Question: What does this figure show? Answer in one sentence.
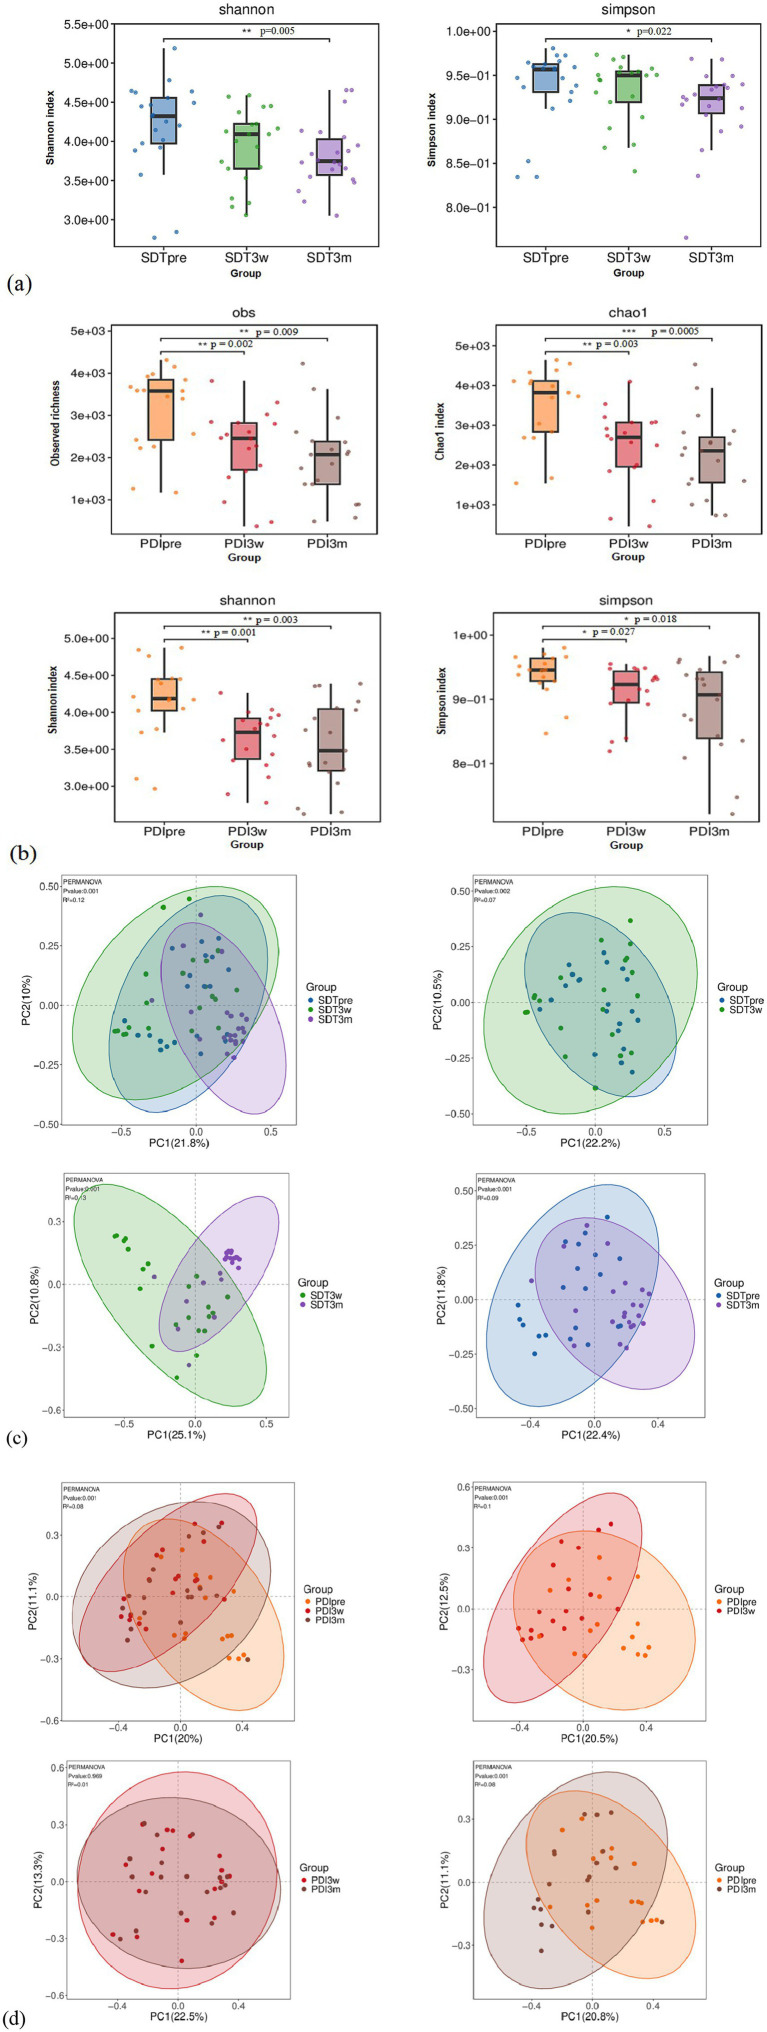
Answer: Within-group longitudinal changes in gut microbiota diversity. (a,b) α-diversity indices (Shannon, Simpson, Obs, and Chao1) in the SDT (a) and PDI (b) groups at preoperation (Pre), 3 weeks (3w), and 3 months (3 m) postoperatively. Box plots show the median, interquartile range, and distribution. Statistical significance is indicated above the plots (* p < 0.05, ** p < 0.01, *** p < 0.001). (c,d) PCoA based on Bray–Curtis distance illustrating structural shifts across the three time points in the SDT (c) and PDI (d) groups. Each dot represents one sample; percentages in parentheses indicate variance explained by each principal coordinate (PC). Between-time-point differences were assessed by PERMANOVA (999 permutations), with p -values and R 2 values shown in the panels. SDTpre, samples collected 1 day preoperatively from the stent-based diversion technique group; SDT3w, samples collected 3 weeks postoperatively from the stent-based diversion technique group; SDT3m, samples collected 3 months postoperatively from the stent-based diversion technique group; PDIpre, samples collected 1 day preoperatively from the prophylactic double-lumen ileostomy group; PDI3w, samples collected 3 weeks postoperatively from the prophylactic double-lumen ileostomy group; PDI3m, samples collected 3 months postoperatively from the prophylactic double-lumen ileostomy group.